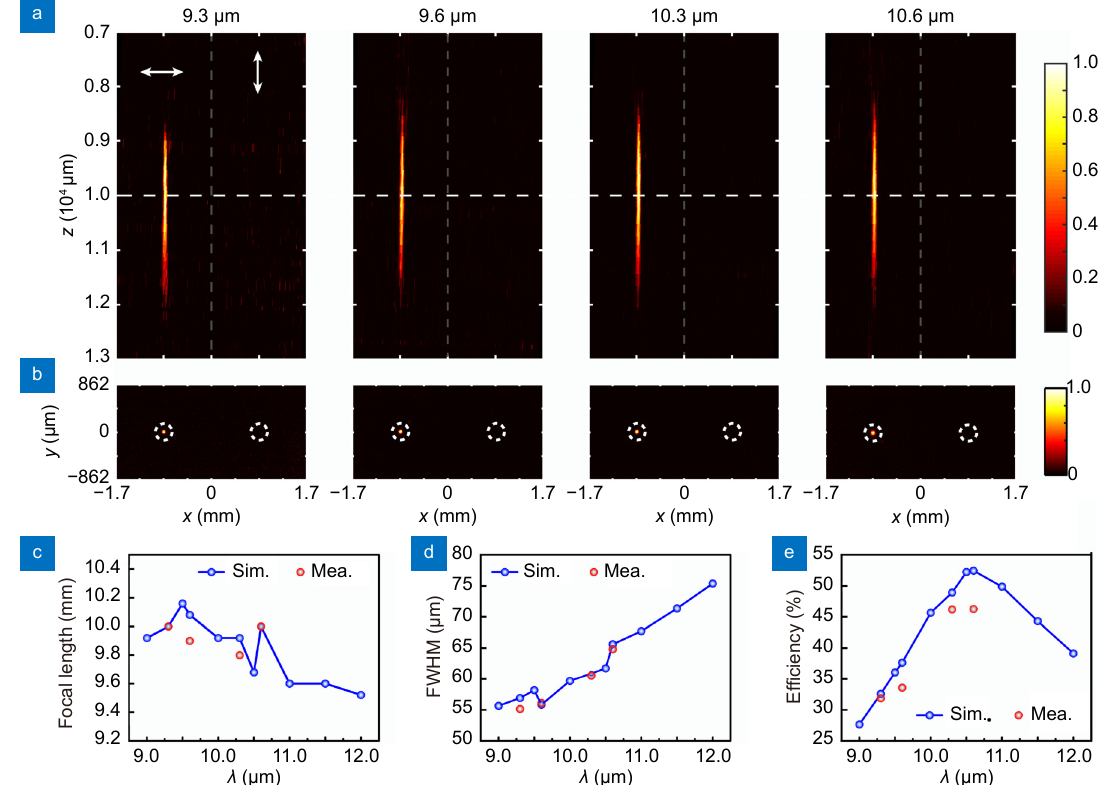
Fig. 5 | Optical Performances of the broadband achromatic metalenses for linear polarization. ( a ) The X and Y polarization-sensitive metalenses measured intensity distributions in the x - z plane at sampled incident wavelengths for 9.3, 9.6, 10.3, and 10.6 μm under X polarized incidence. The white dashed lines are the position of the focal plane. ( b ) The measured focal plane intensity distributions. ( c ) The extracted focal lengths of the simulation and experiment are a function of wavelength, and all focal lengths are around the target 1 cm. ( d ) The measured and simulated FWHMs of the focal spots versus the sampled wavelengths. ( e ) The measured and simulated focusing efficiencies. The blue solids represent the corresponding theoretical results at 9, 9.3, 9.5, 9.6, 10, 10.3, 10.5, 10.6, 11, 11.5, and 12 μm, and the red solids represent the ex- perimental results at 9.3, 9.6, 10.3, and 10.6 μm. Exp.: experiment. Sim.: